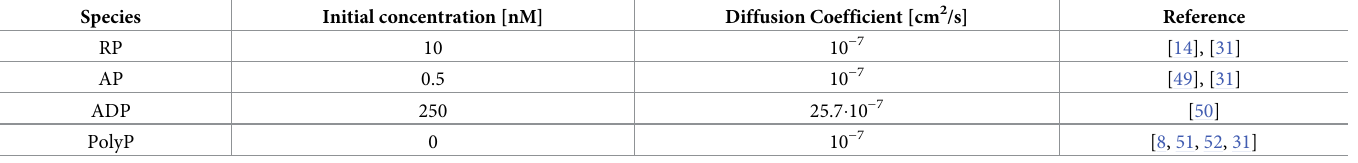
Table 1. Initial conditions and diffusion coefficient values for Reaction-Advection-Diffusion (RAD) equations.